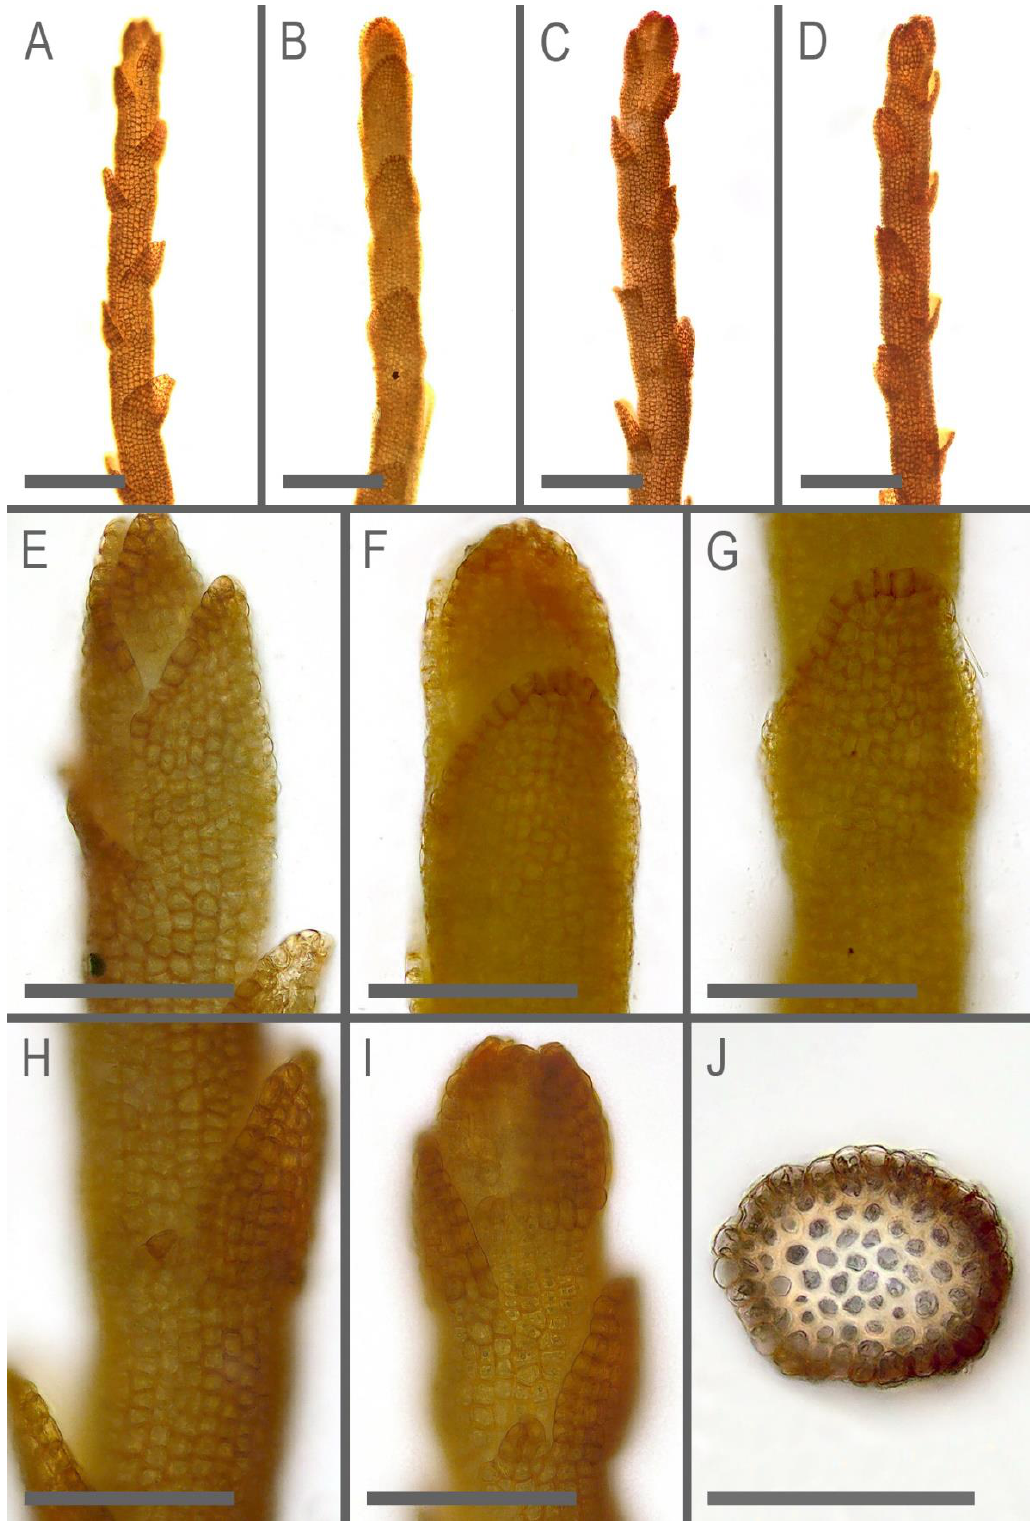
Figure 6. Marsupella praetermissa Bakalin et Vilnet sp. nov. : ( A ) shoot, fragment, dorsal view; ( B ) shoot, fragment, lateral view; ( C , D ) shoot, fragment, ventral view; ( E ) shoot apex, dorsal view; ( F ) shoot apex, lateral view; ( G ) shoot fragment, lateral view; ( H ) shoot fragment, ventral view; ( I ) shoot apex, ventral view; ( J ) stem cross-section. Scales: 200 µm for ( A – D ); 100 µm for ( E – J ). All from Holotype Long 35,742 (E).